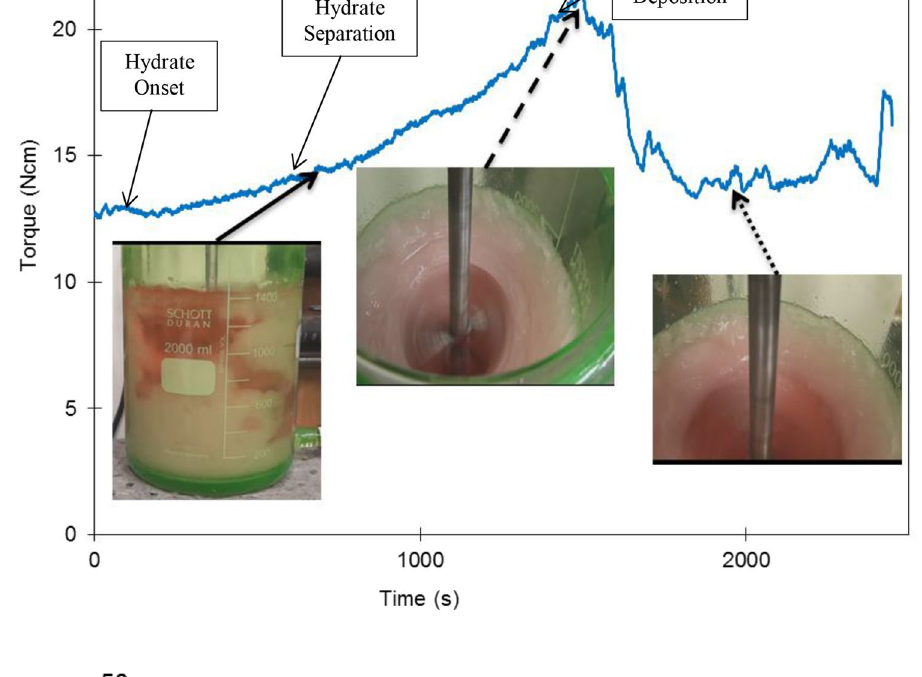
Fig. 4 Effect of mixer speed on hydrate slurry behavior. W.C watercut, SF solid